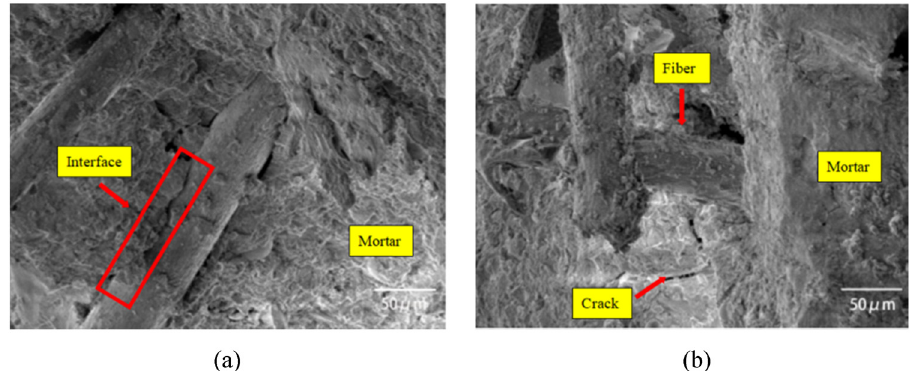
Figure 11: The SEM images of PVA fi ber in O 2 specimen. ( a ) Fiber surface and ( b ) fi ber port.